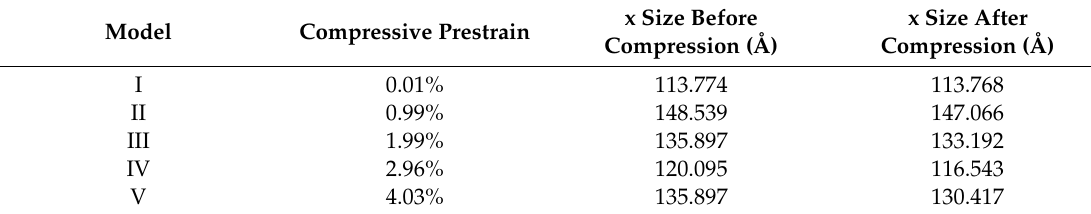
Table 1. Prestrain parameters of MoS 2 along the x -direction